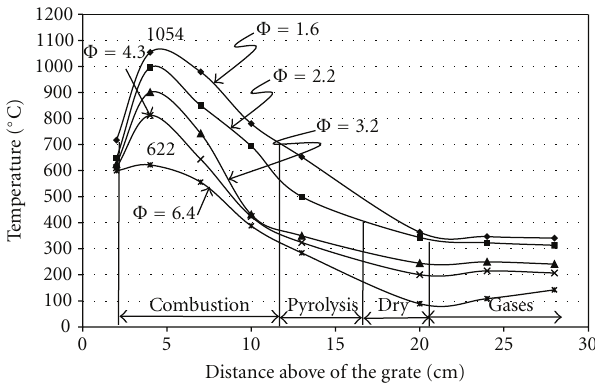
Figure 1: Temperature profile along the gasifier axis for gasification of DBWC blend at S : F = 0 . 4, adapted from [11].